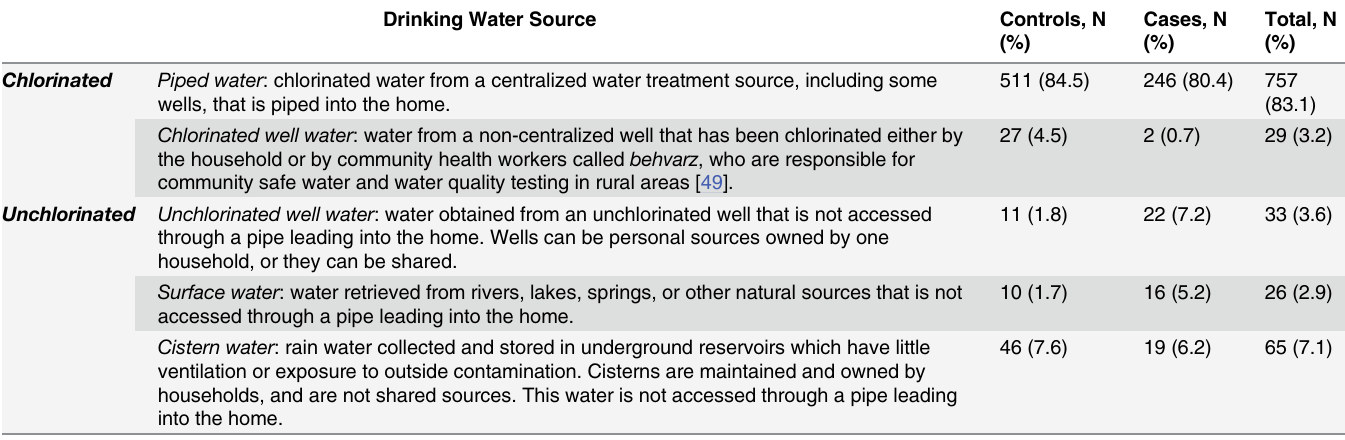
Table 2. Water Source